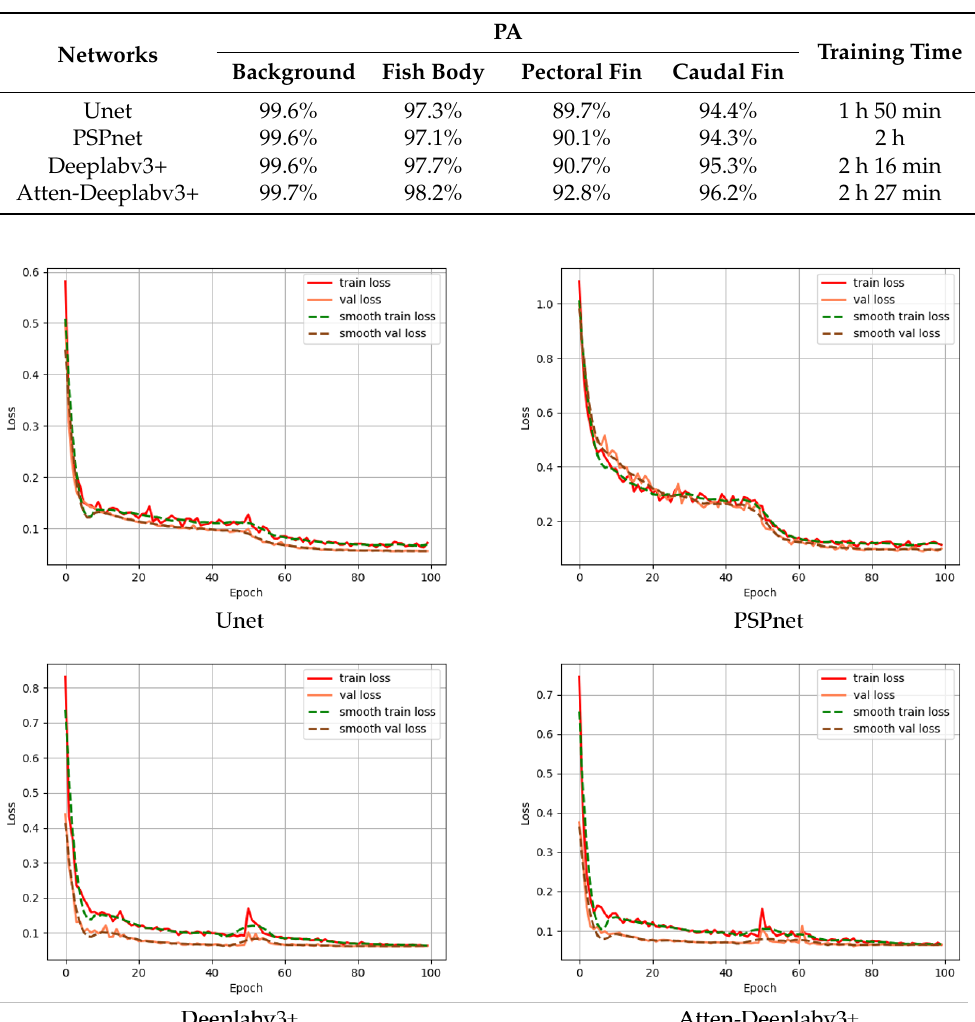
Table 2. Comparison of results among semantic segmentation networks.